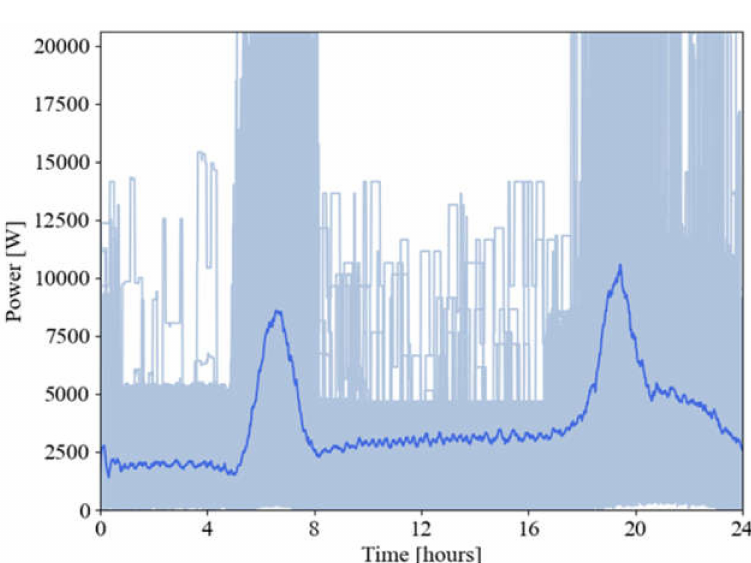
Figure 3. Load profile of a random day in the model community based on TVSEP data as well as load demand profiles, retrieved from RAMP